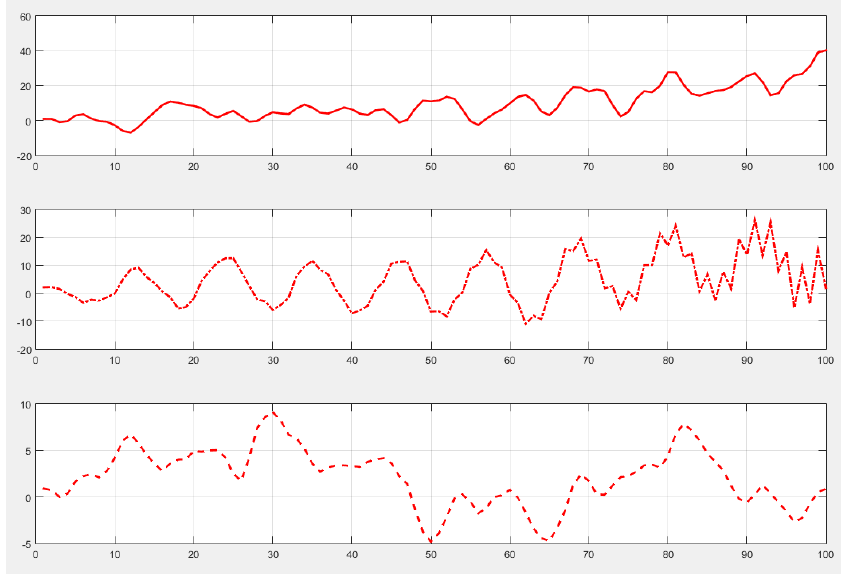
Fig. 6 Time domain presentation of signals from CF based on phrase No.